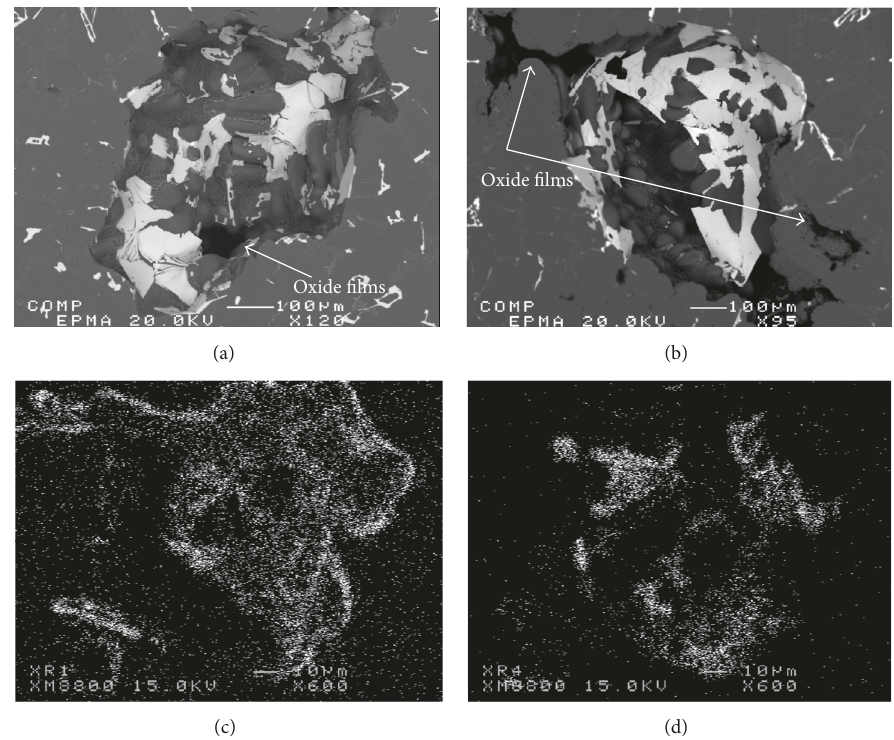
Figure 15: (a, b) Backscattered electron images showing porosity in Sr-modified A356 alloy samples containing (a) 0.8% La and (b) 1.025% La; note the presence of thick oxide films (white arrows) (sample SDAS ∼ 42 𝜇 m). (c, d) X-ray images showing the distribution of (c) oxygen and (d) strontium in